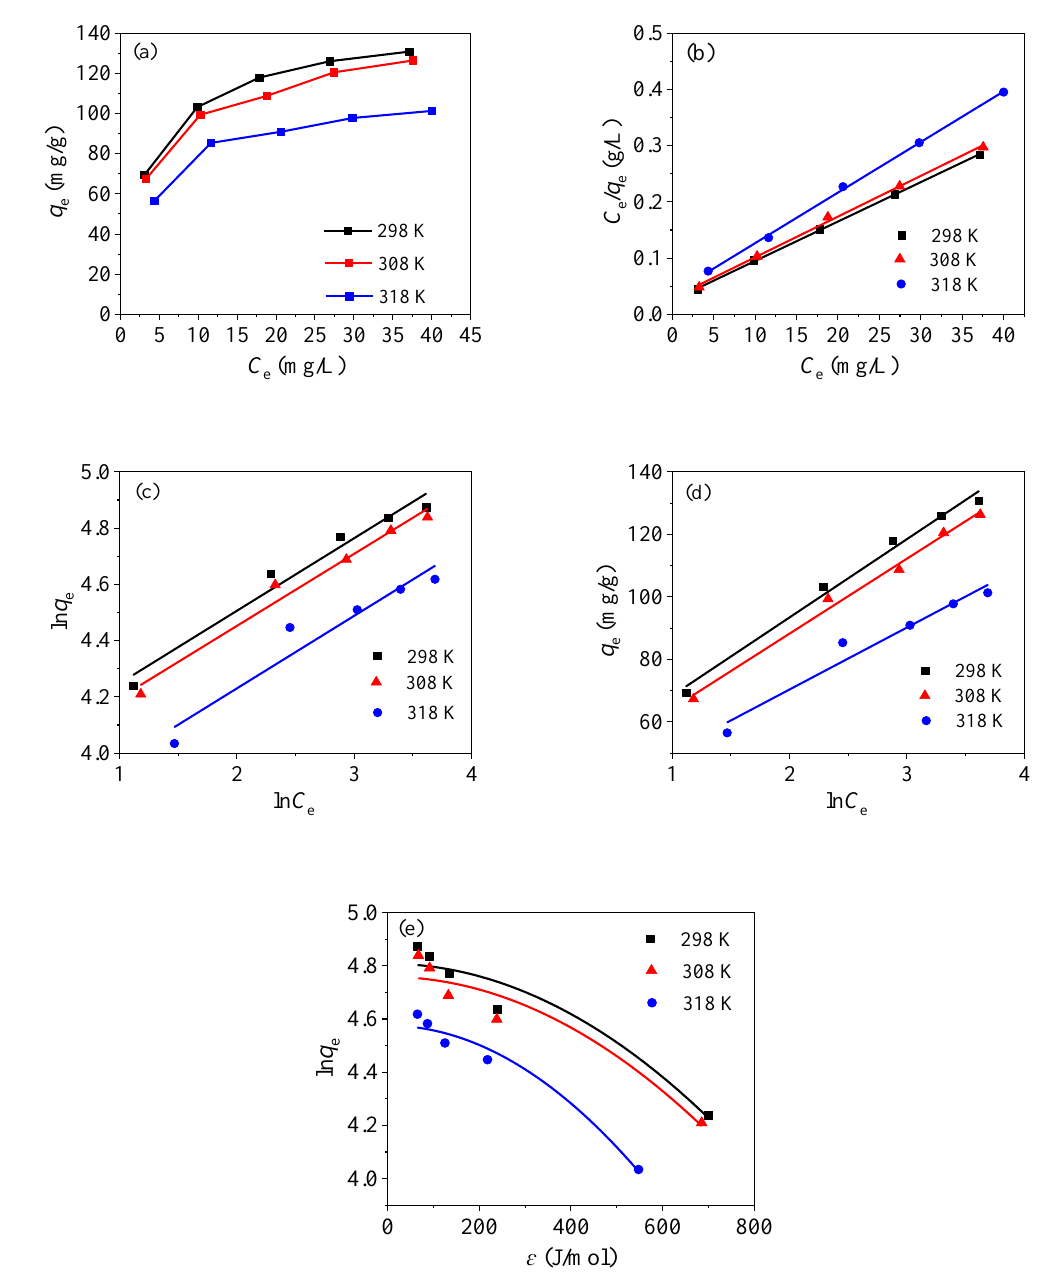
Figure 13. Adsorption isotherm of CoFe 2 O 4 @SiO 2 -EDTA on Hg(II) ( a ), Langmuir ( b ), Freundlich ( c ), Temkin ( d ), and Dubinin–Radushkevich ( e ).